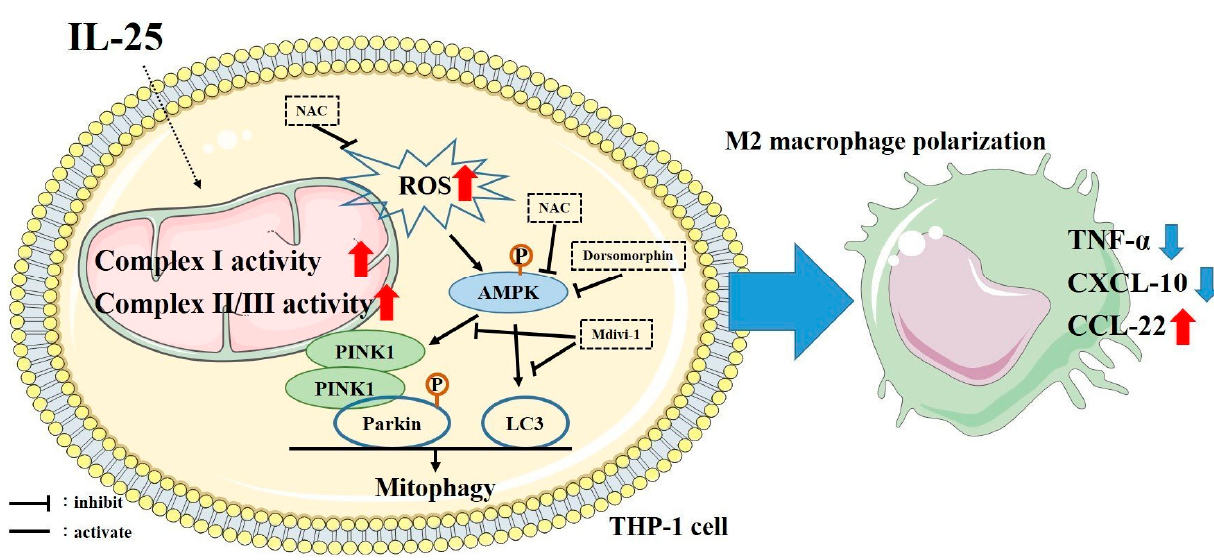
Figure 7. Schematic of the proposed intracellular mechanisms underlying IL-25-induced M2 macrophage polarization. IL-25 increased ROS production and mitochondrial complex I and complex II/III activity. Subsequently, activation of mitophagy, and then shifted M1/M2 chemokine expression via the AMPK signaling pathway in human monocyte cell line.